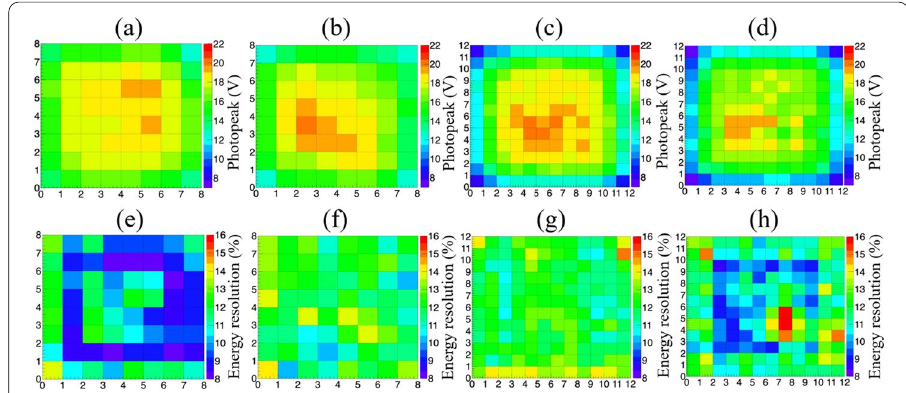
Fig. 8 Photopeak amplitudes (top) of all individual crystals of the four detectors measured from the pulse height spectra of all depths, a detector 1, b detector 2, c detector 3, and d detector 4. Energy resolutions (bottom) of all individual crystals of the four detectors measured from the energy spectra of all depths, e detector 1, f detector 2, g detector 3, and h detector 4